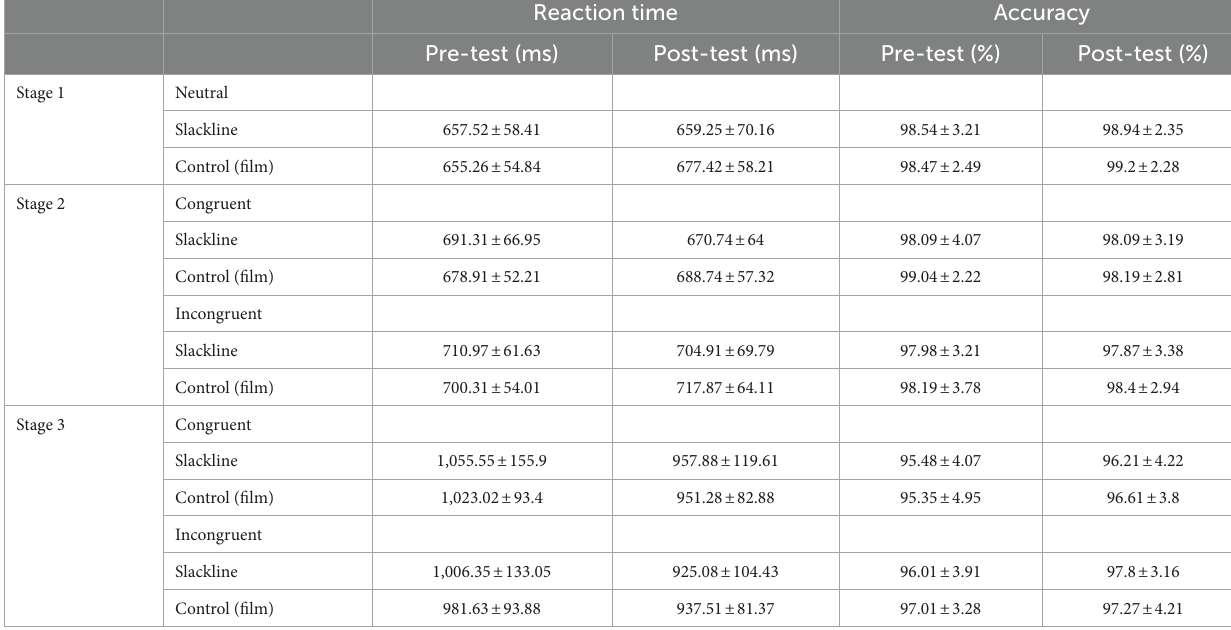
TABLE 2 Reaction time and accuracy in the modified Simon task for each intervention (M ±